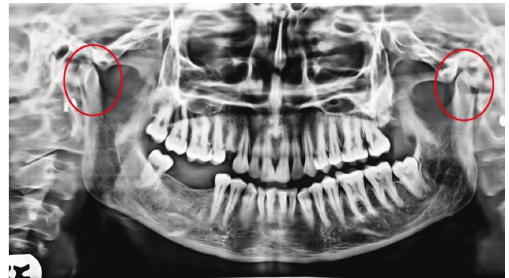
Figure 6: Panoramic view showing irregular erosion on right and left side of condyle with flattening of articular eminence.